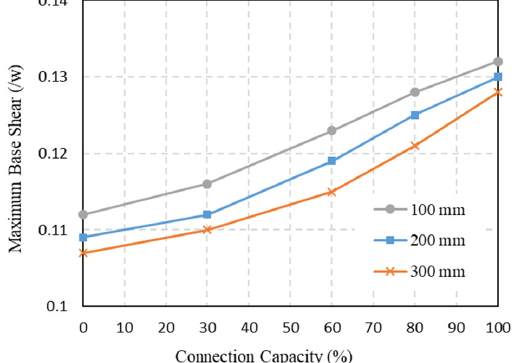
Figure 28. Maximum base shear of 15-story frame subjected to 5 earthquake records.